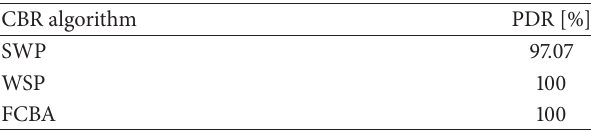
Table 7: Packer delivery ratio (PDR) comparison.